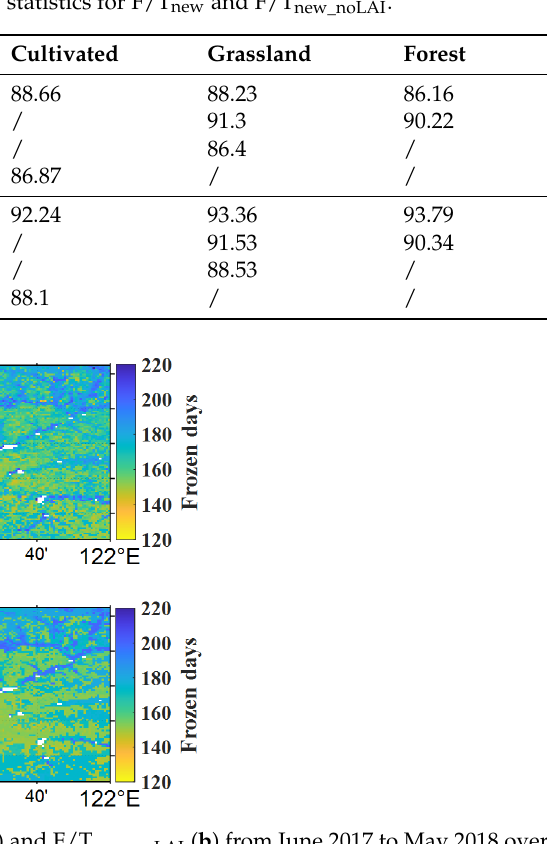
Figure 19. A comparison of thawed ( a ), frozen ( b ) and total ( c ) accuracies between F/T new and F/T new_noLAI . Table 6. Total classification accuracy (%) statistics for F/T new and F/T new_noLAI .